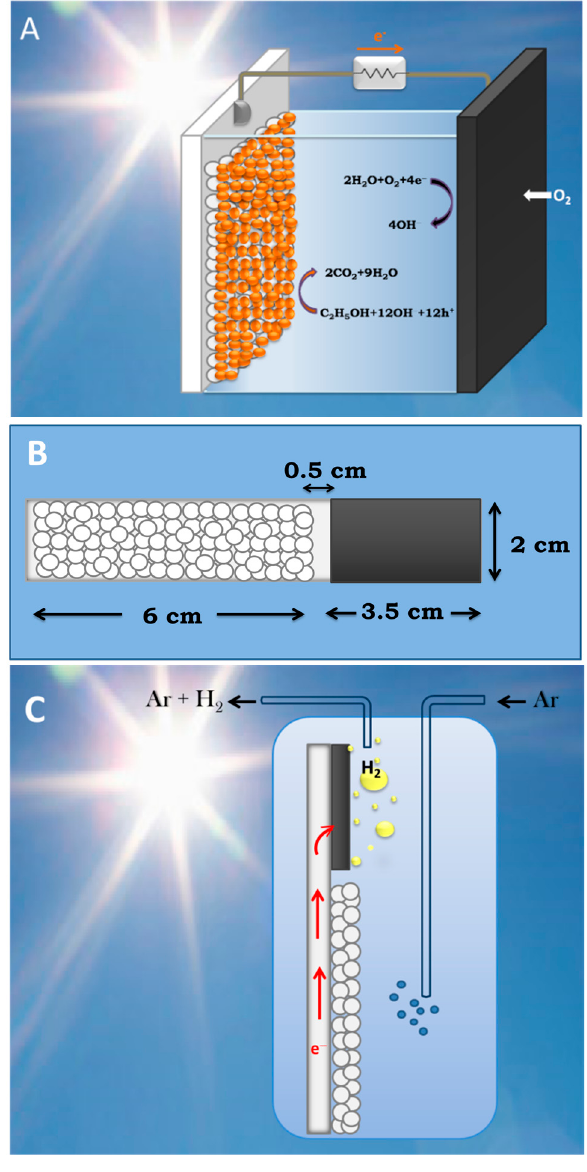
Figure 2. Design of reactors and electrodes: ( A ) Design of a PFC exclusively producing electricity; ( B ) Geometrical distribution of photocatalyst (small circles) and electrocatalyst (black area) on a “photoelectrocatalytic leaf”; and ( C ) Production of hydrogen using the “photoelectrocatalytic